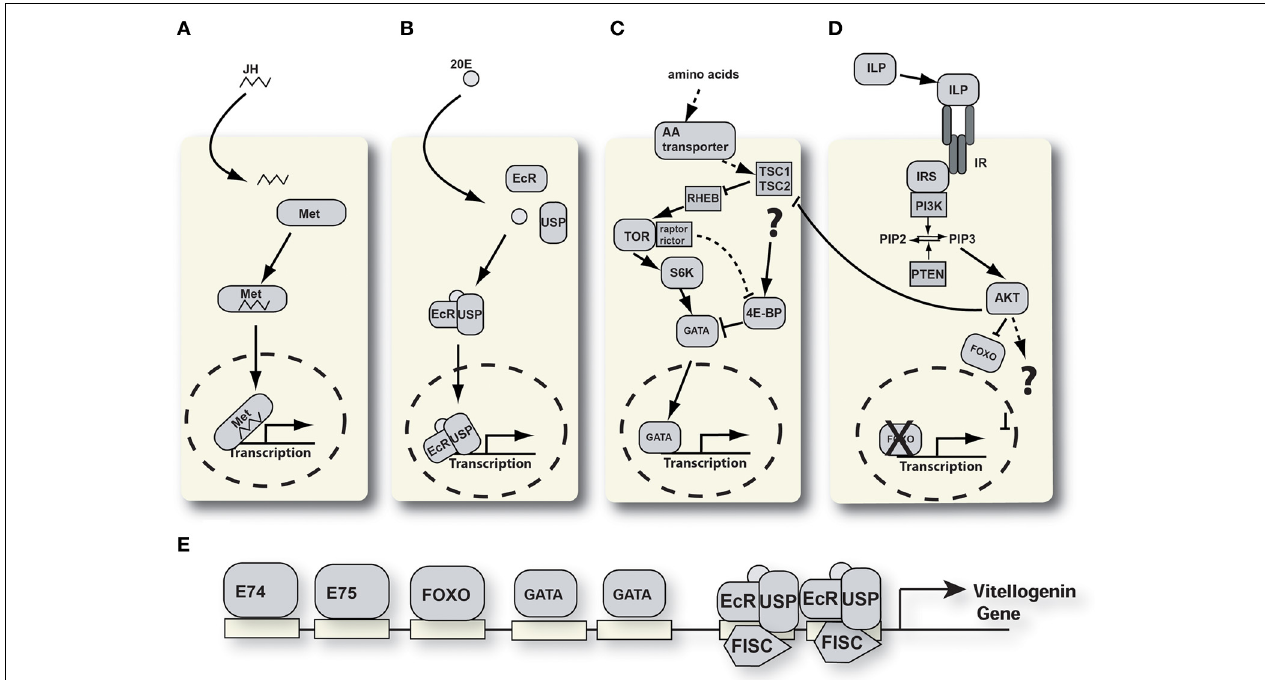
FIGURE 2 | Signaling pathways involved in YPP regulation. (A) Juvenile hormone signaling pathway. JH, juvenile hormone; Met, methoprene tolerant. (B) Ecdysone signaling pathway. 20E, 20 hydroxyecdysone; EcR, ecdysone receptor; USP, ultraspiracle. (C) Nutrient signaling pathway. 4E-BP, 4E-binding protein; TSC, tuberous sclerosis complex; RHEB, RAS homologue enriched in brain; S6K, S6 kinase; TOR, target of rapamycin. (D) Insulin-like